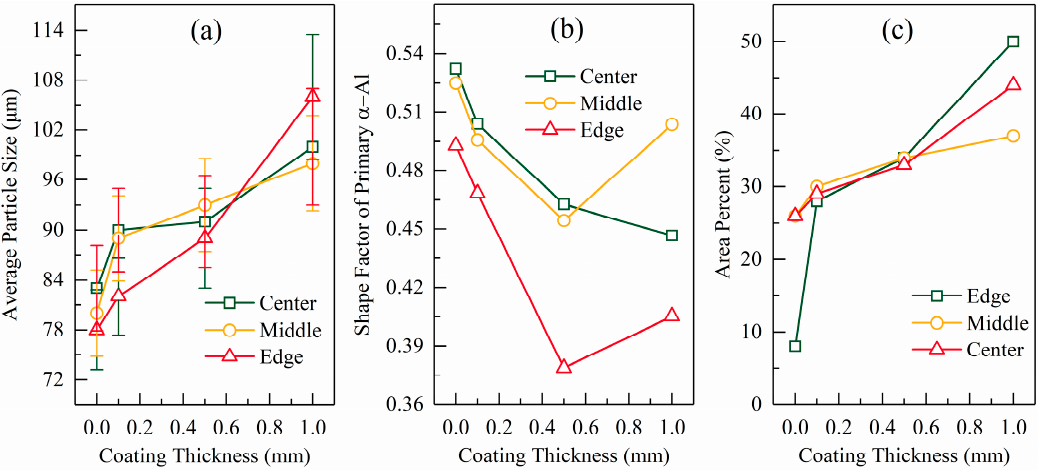
Figure 10. Relationship between coating thickness and ( a ) particle diameter, ( b ) average shape factor, and ( c ) area percentages of grains with sizes larger than 170 µm.